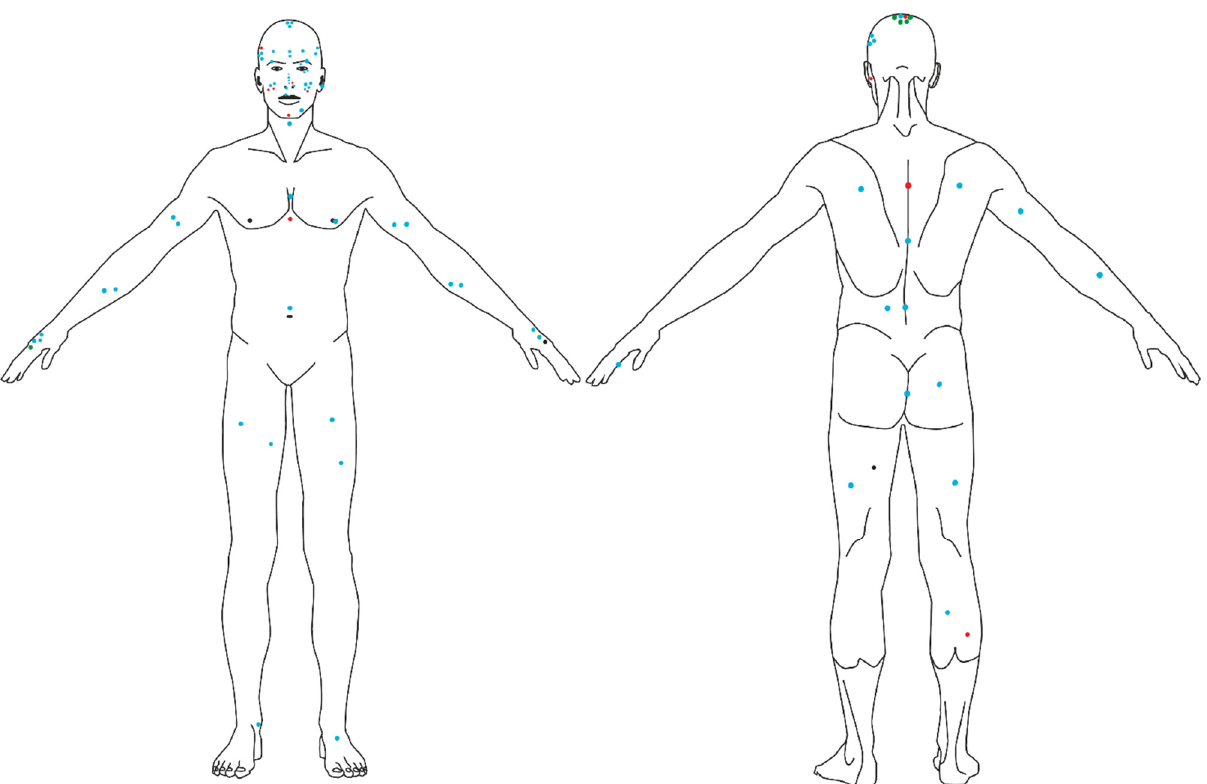
Figure 1. Anatomical distribution of different histopathological subtypes of blue nevi analyzed in the study. Blue dots represent common blue nevi; red dots, combined blue nevi; green dots, cellular blue nevi; black dots, desmoplastic blue nevi.